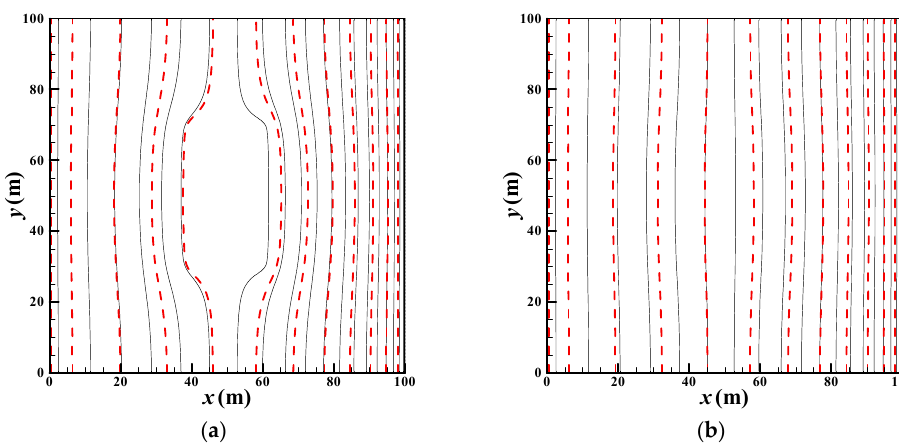
Figure 5. Pressure fields comparison for typical POD modeling at t 2 : black solid line-FDM; red dashed line-POD. ( a ) Fracture ( ε F = 38.67%); ( b ) Matrix ( ε M = 38.98%).